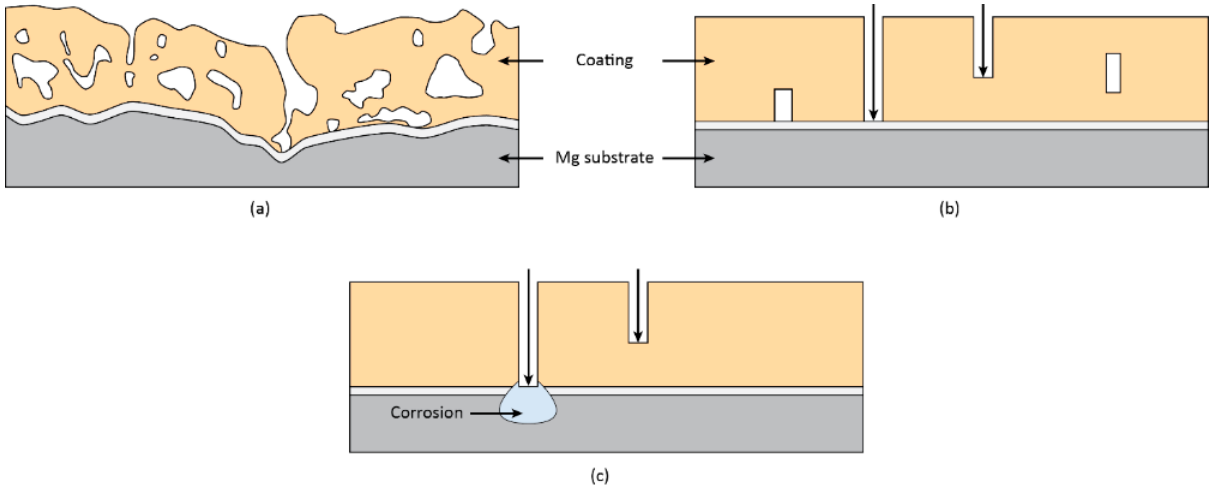
Figure 10. Schematic diagrams of ( a ) PEO coating, ( b ) simplified model of pores, and ( c ) corrosion initiation.